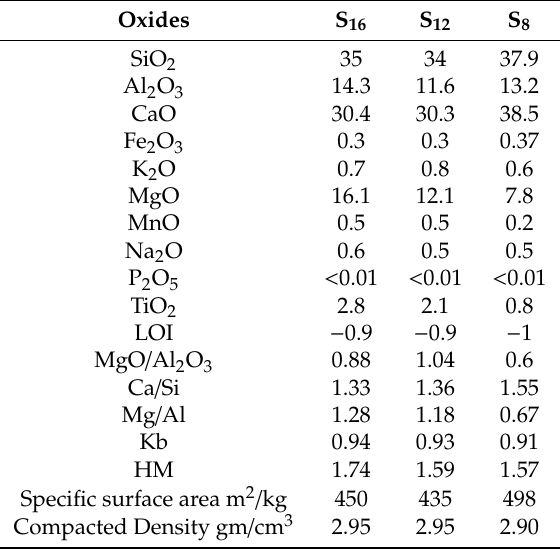
Table 1. The chemical compositions and physical properties of the